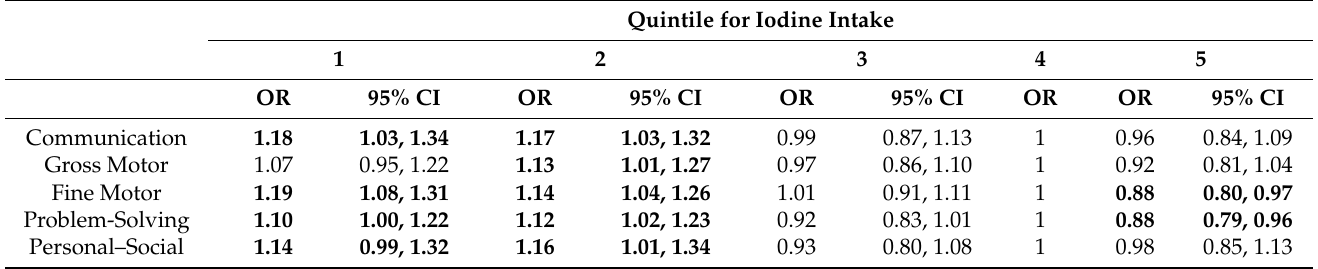
Table 3. Adjusted ORs and 95% CIs for child neurodevelopmental delay at 3 years of age based on maternal iodine intake in multiple binomial logistic regression analysis.